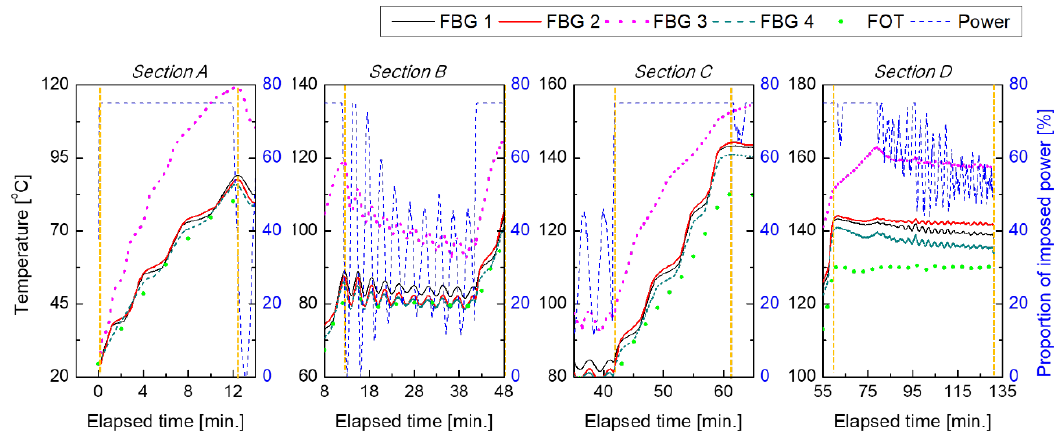
Figure 6. Temperature readings obtained from all sensors during cure monitoring of specimen 1 in 1 S / s and 0.2 S / s sampling rates of FBG sensors and FOT sensor, respectively; (Section A) primary heating, (Section B) primary retention, (Section C) secondary heating, (Section D) secondary retention.